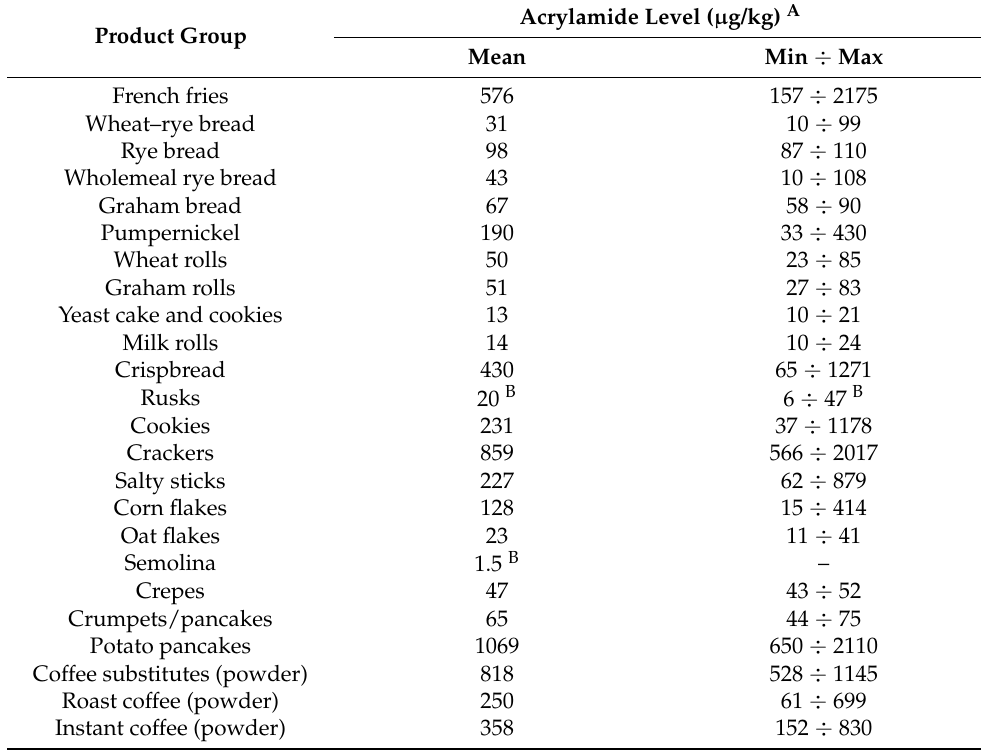
Table 3. Acrylamide level in food products consumed by study women